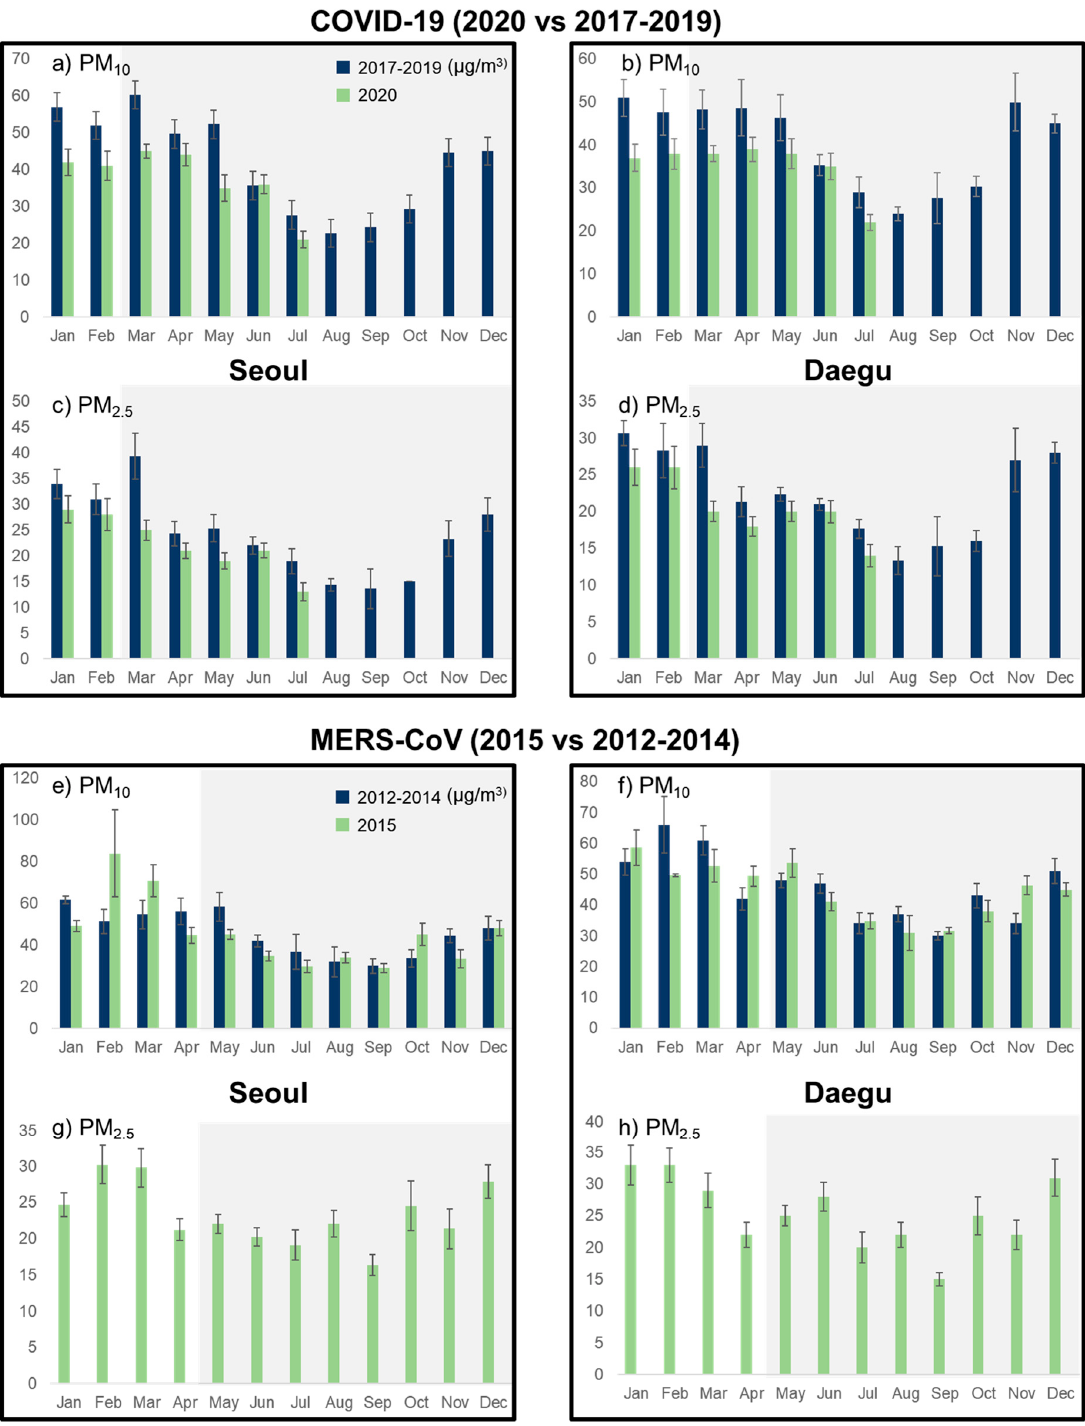
Figure 3. Comparison of PM 2.5 ( μ g/m 3 ) and PM 10 ( μ g/m 3 ) before and after coronavirus outbreak. ( a , c ) Changes in concentrations of particulate matter before and after COVID-19 in Seoul. ( b , d ) Changes in concentrations of particulate matter before and after COVID-19 in Daegu. ( e , g ) Changes in particulate matter before and after MERS-CoV in Seoul. ( f , h ) Changes in particulate matter before and after MERS-CoV in Daegu. (PM 2.5 has been monitored since